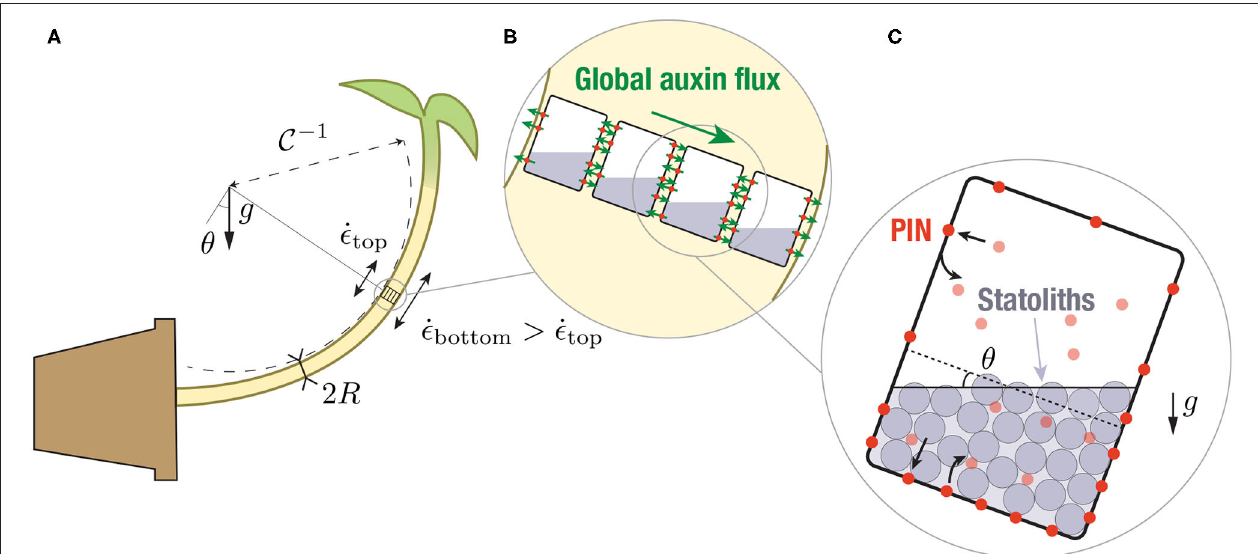
FIGURE 1 | Multiscale description of gravitropism. At the macroscopic scale (A) , the response to gravity of a shoot or a stem is achieved by differential growth across the organ, which induces a curvature of the organ. At the tissue scale (B) , differential growth results from a net flux of the auxin across the width (large green arrows), owing to the asymmetric distribution of auxin transporters (PINs, red circles). The local auxin fluxes are shown by the small green arrows. At the cell scale (C) , PIN asymmetry results from the asymmetric distribution of the statoliths position after sedimentation under gravity, which modifies PIN trafficking close to the cell